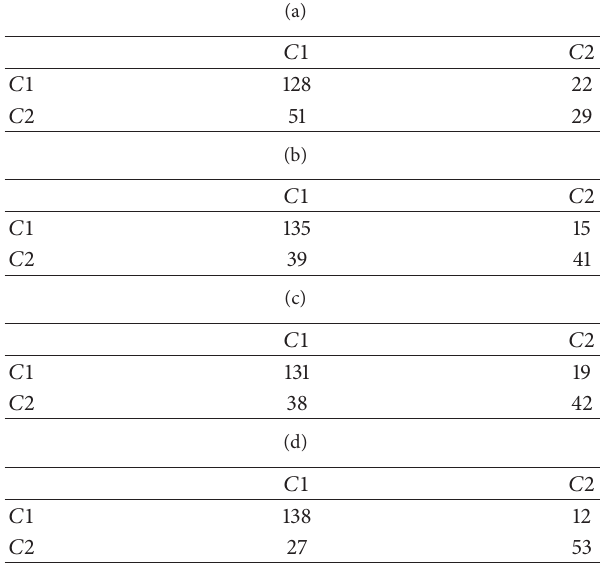
Table10:Confusionmatricesof(a)Adaboost,(b)Bagging,(c)RSM, and (d) proposed approach using Pima Indian Diabetes dataset.